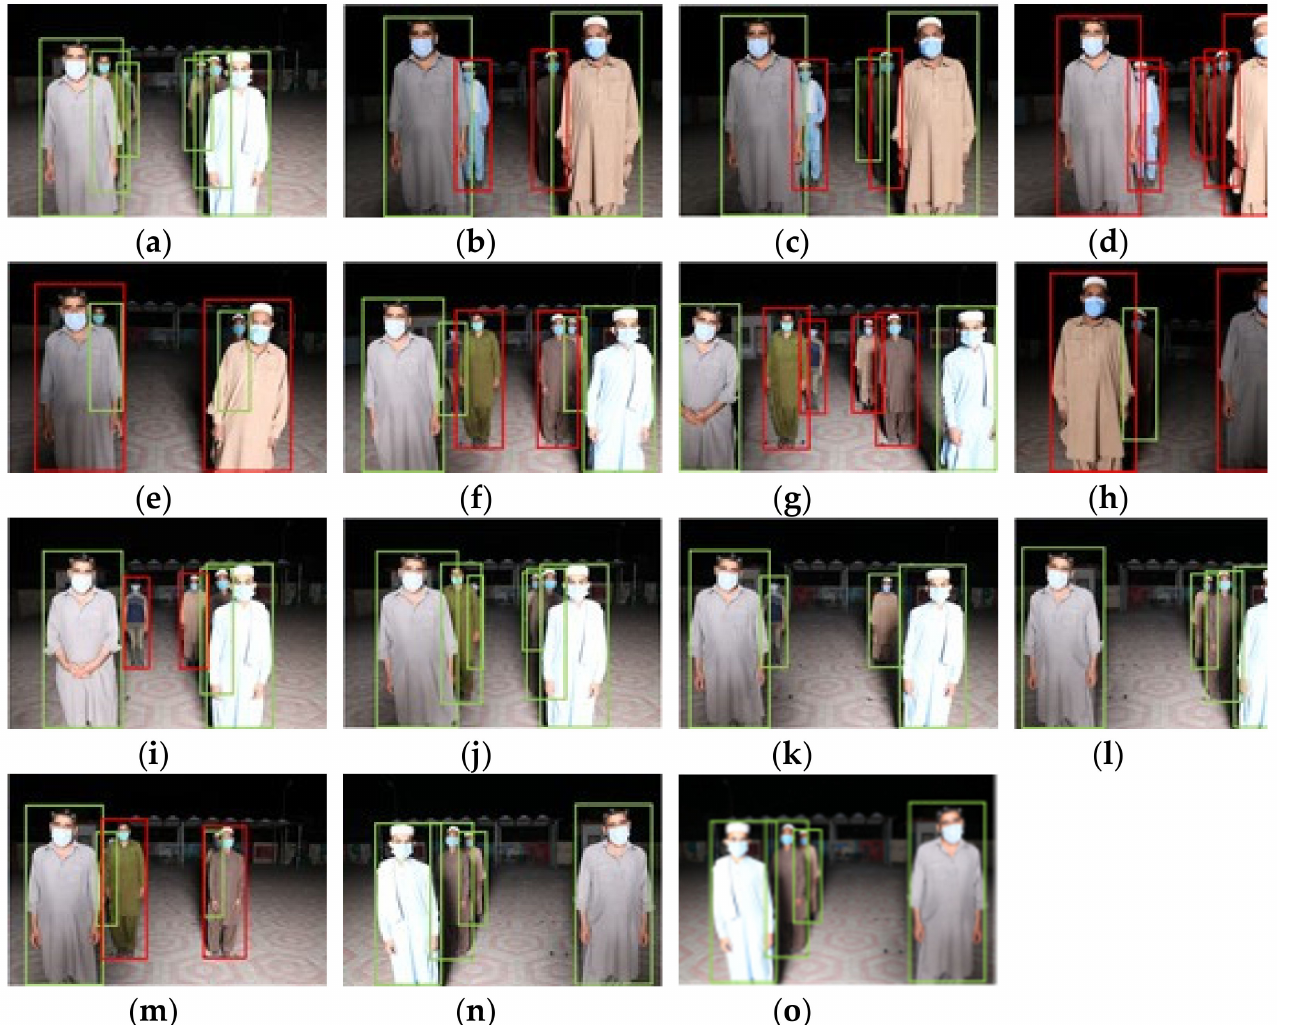
Figure 8. Qualitative evaluation of the DepTSol model. SubFig ( a – o ) represents frames whose quantitative evaluation is depicted in Table 3.